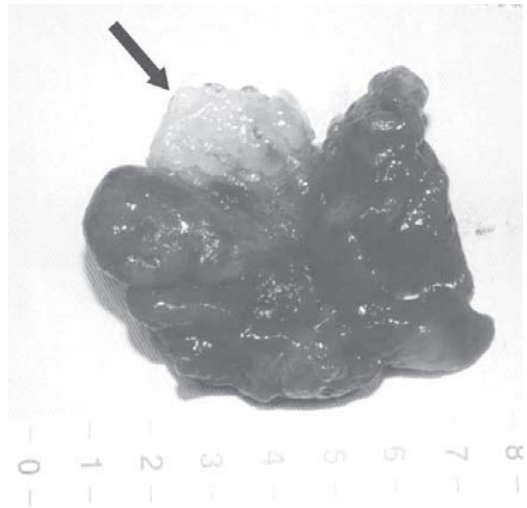
Fig. 3 - Aspecto macroscópico do mixoma atrial esquerdo. A região mais esbranquiçada (seta) corresponde ao pedículo da